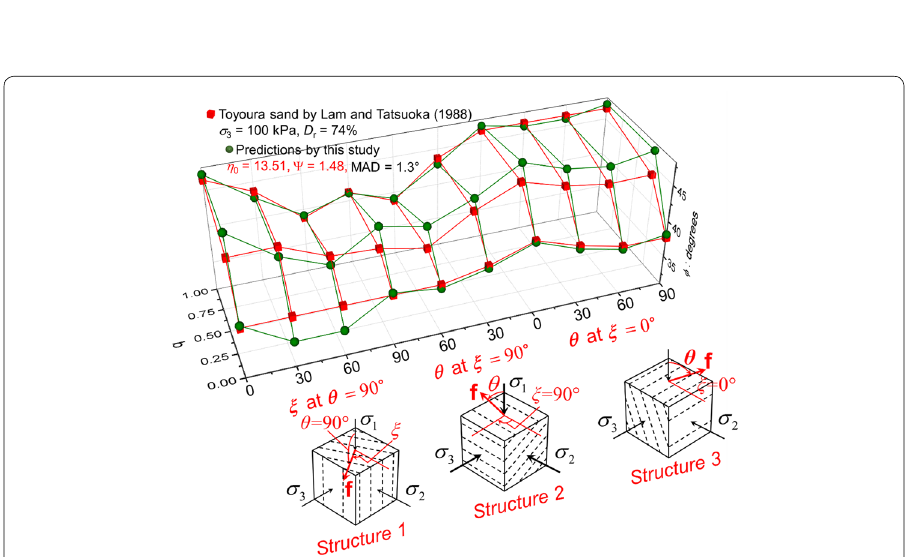
Fig. 20 Comparison between experimental results of Toyoura sand by Lam and Tatsuoka [15] and predictions by this